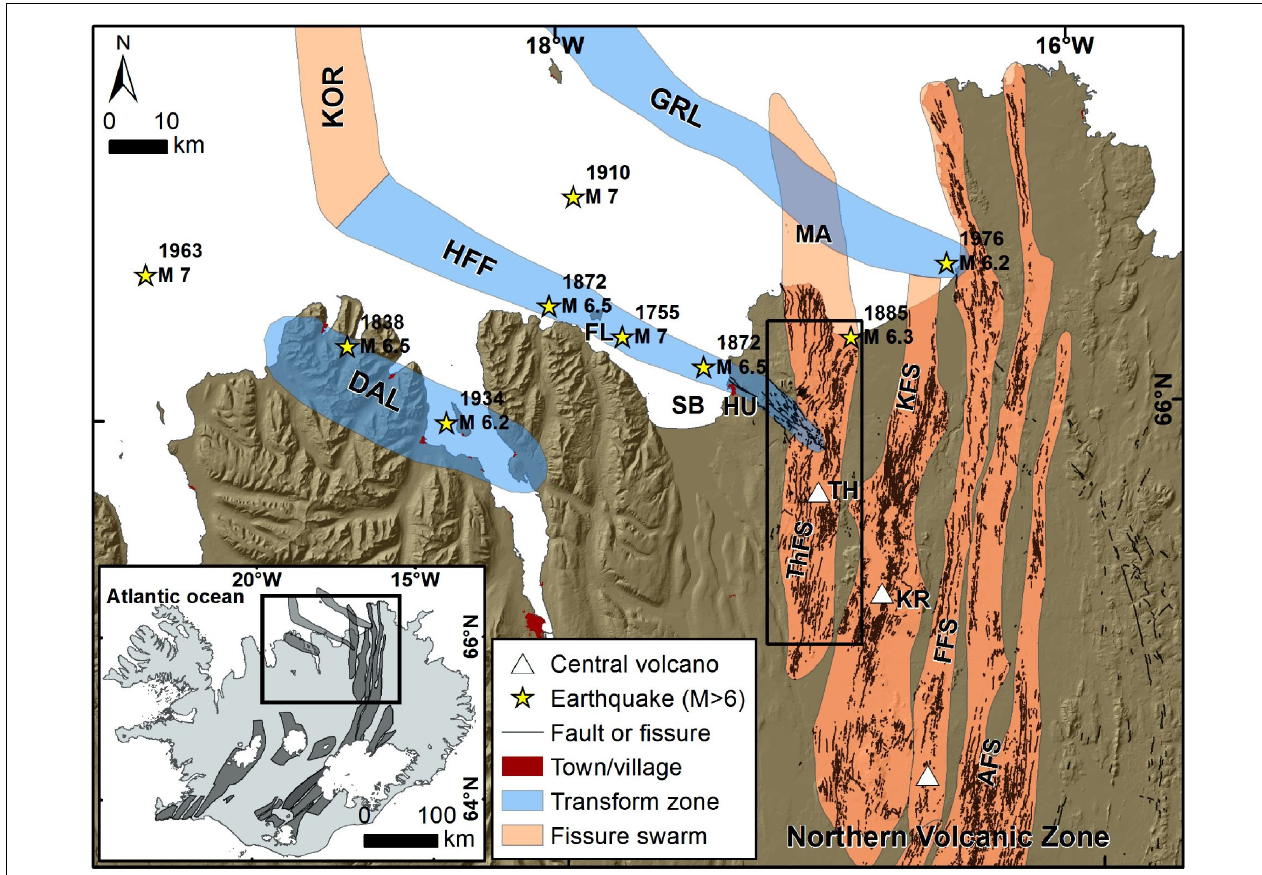
FIGURE 2 | Tectonic setting of northeastern Iceland. Within the North Volcanic Zone, the Mid-Atlantic Ridge is offset by the Húsav ı k-Flatey Fault (HFF) and by the Grimsey Lineament (GRL), which, together with the Dalvík Lineament (DAL), compose the Tjörnes Fracture Zone. Yellow stars locate historical earthquakes with M > 6 (after Stefansson et al., 2008). Orange stripes represent volcano-tectonic rift zones, also termed “fissure swarms,” where the main normal faults, extension fractures and volcanic fissures are shown (after Magnúsdóttir and Brandsdóttir, 2011; Hjartardóttir et al., 2012, 2015); Quaternary central volcanoes are highlighted as white triangles. Box locates ( Figure 4A ). The inset shows the location of the area and the main volcano-tectonic rift zones of Iceland (after Einarsson and Saemundsson, 1987; Hjartardóttir et al., 2016a); the black rectangle locates the Tjörnes Fracture Zone and the NVZ. The cartographic data is from the National Land Survey of Iceland AFS, Askja Fissure Swarm; DAL, Dalvík Lineament; FFS, Fremrinámar Fissure Swarm; KFS, Krafla Fissure Swarm; KR, Krafla central volcano (triangle); KOR, Kolbeinsey Ridge; HU, town of Húsavik; MA, Mánáreyjar eruptive site of 1867; SB, Skjálfandi Bay; TH, Theistareykir central volcano; ThFS, Theistareykir Fissure Swarm. Spatial reference: datum WGS 84/Geographic